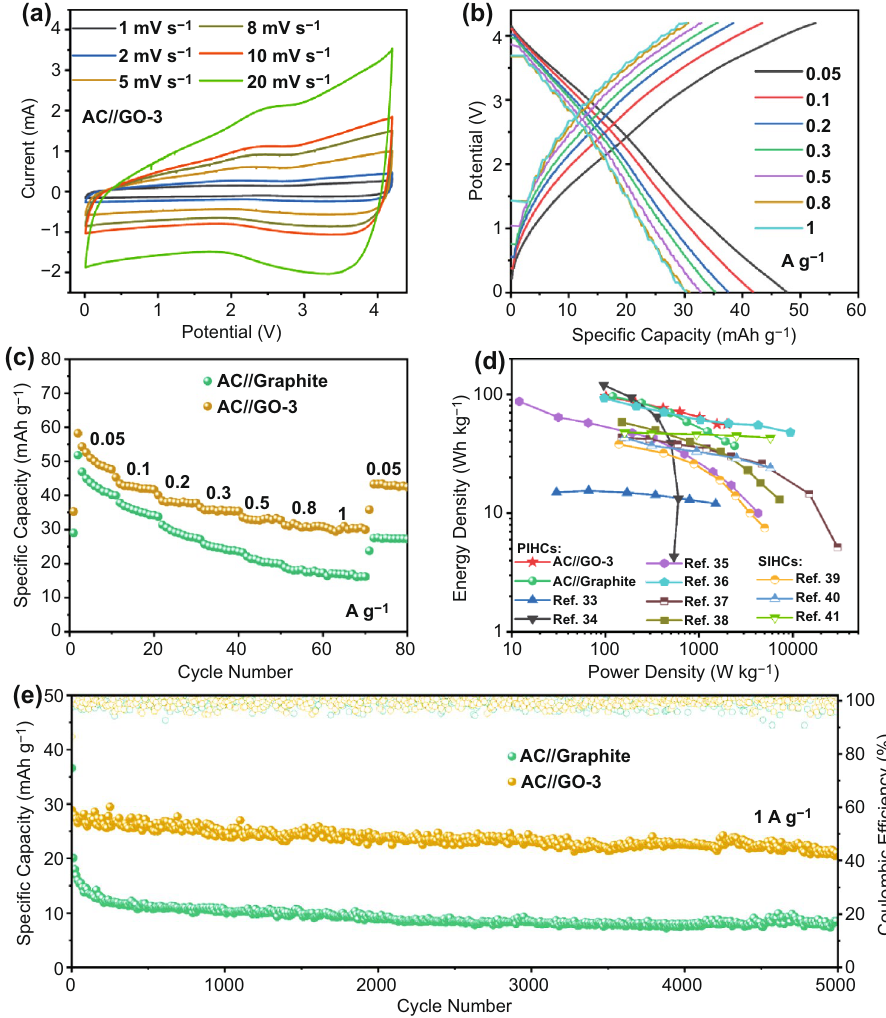
Fig. 5 Electrochemical performance of PIHCs using graphite or GO anode and AC cathode. a CV curves of AC//GO-3. b GCD profiles of AC// GO-3. c Rate capability of the PIHCs. d Ragone plots of the PIHCs. e Long-term cycle performance of the